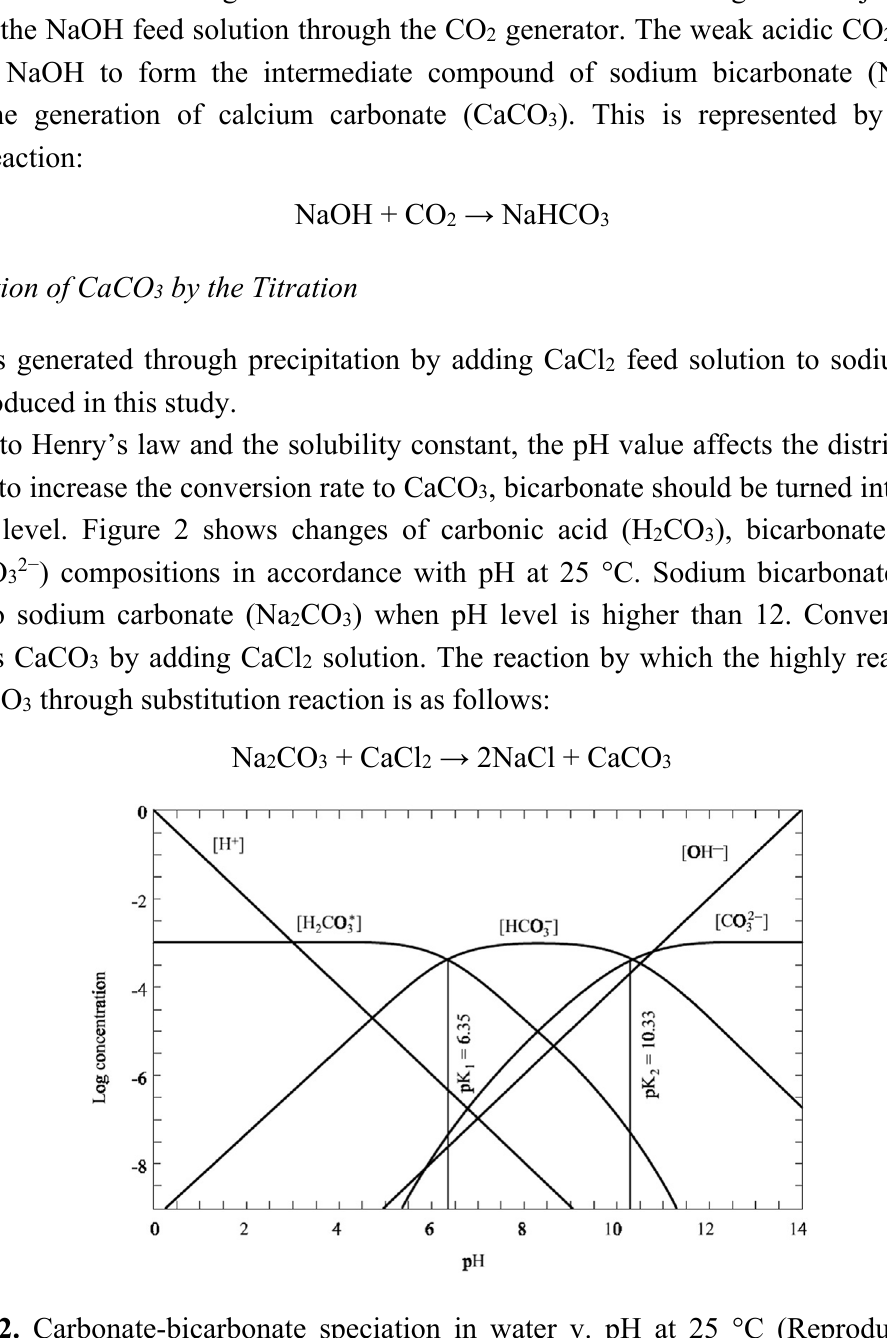
Figure 2. Carbonate-bicarbonate speciation in water v. pH at 25 °C (Reproduced with permission from [26]. Copyright 2012, John Wiley &